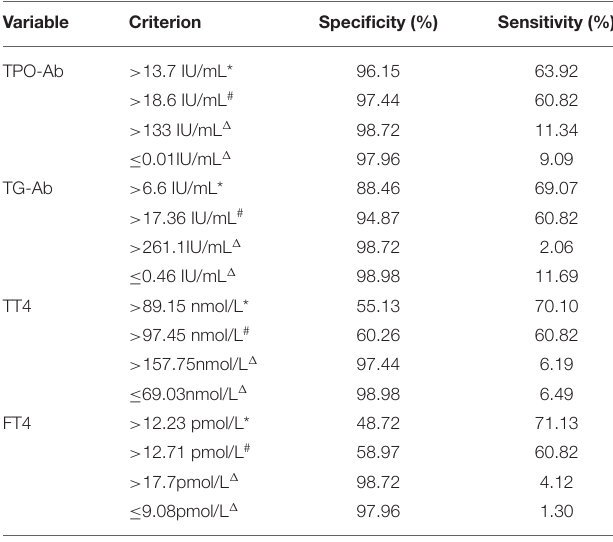
TABLE 4 | List of cut-off value, sensitivity, and specificity of thyroid function and autoantibodies in GBS and CIDP ROC